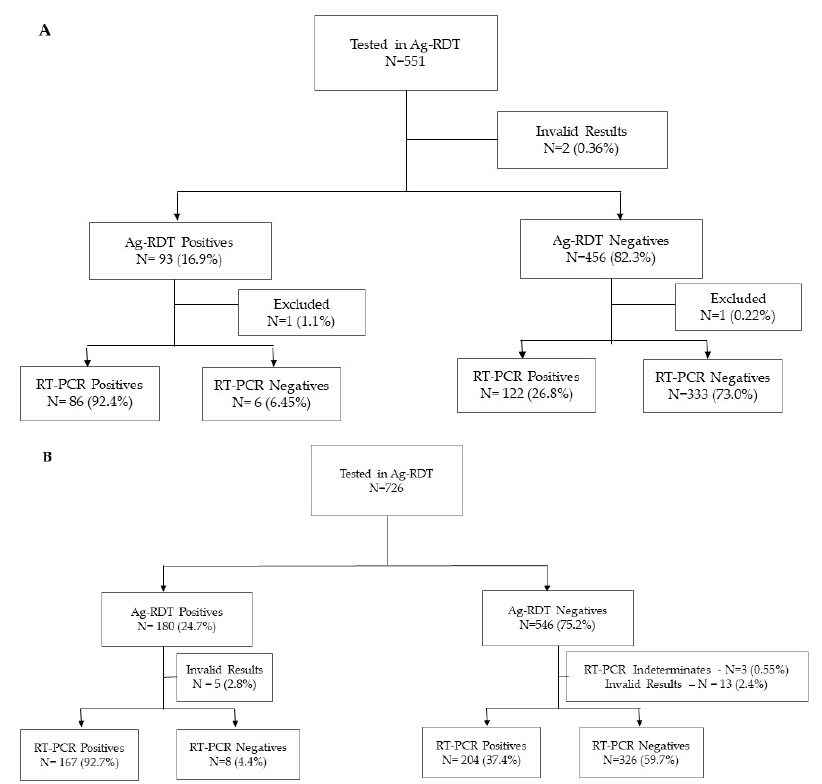
Figure 1. Flow diagram of study participants tested by RT-PCR and Panbio TM COVID-19 Ag rapid test ( A ) and STANDARD Q COVID-19 Ag Test ( B ). Table 1. Characteristics of study participants.